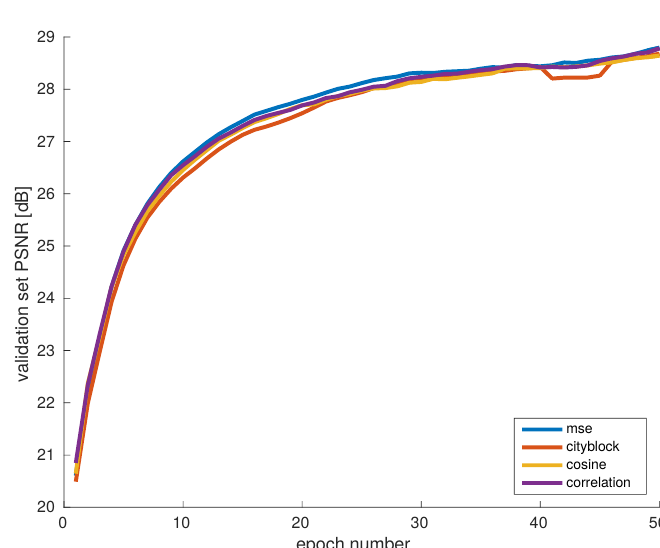
Figure 7. Evaluation of the effect of different distance metrics for data clustering. The experiments show no significant impact of the choice of distance metric on training